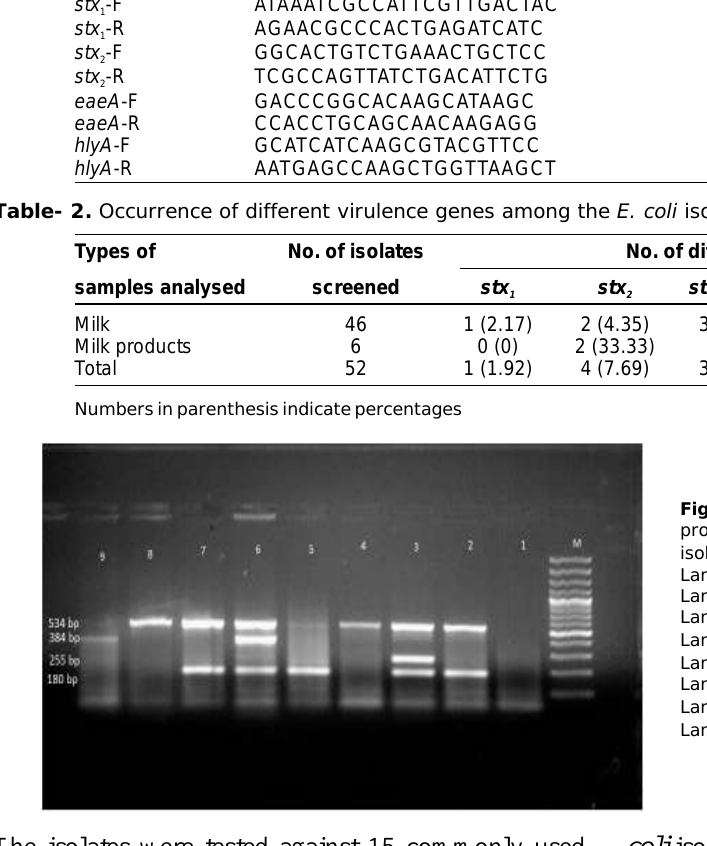
Table- 1. List of primers (5'-3') used in the mPCR reaction Primer